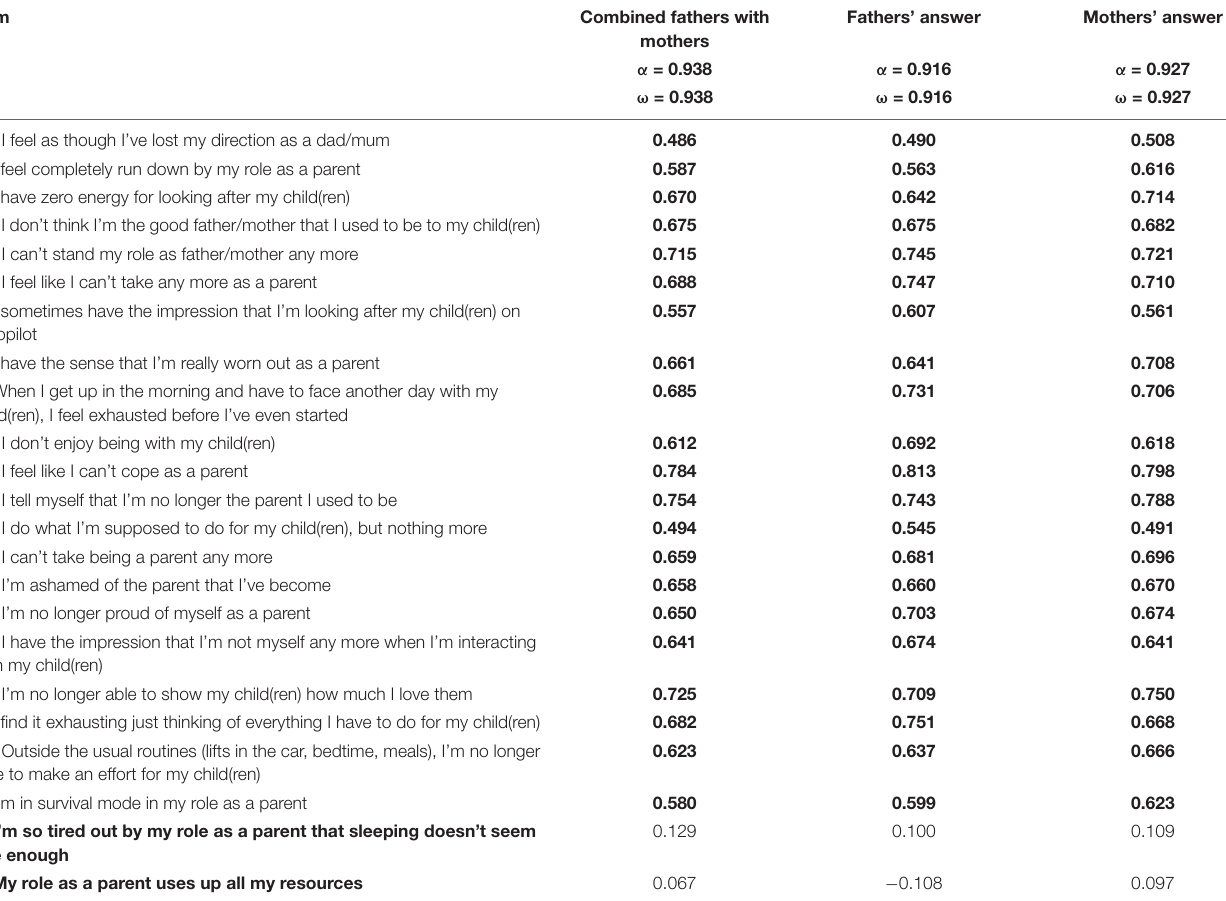
TABLE 1 | Results of the exploratory factor analysis (maximum likelihood estimation and Promax rotation).